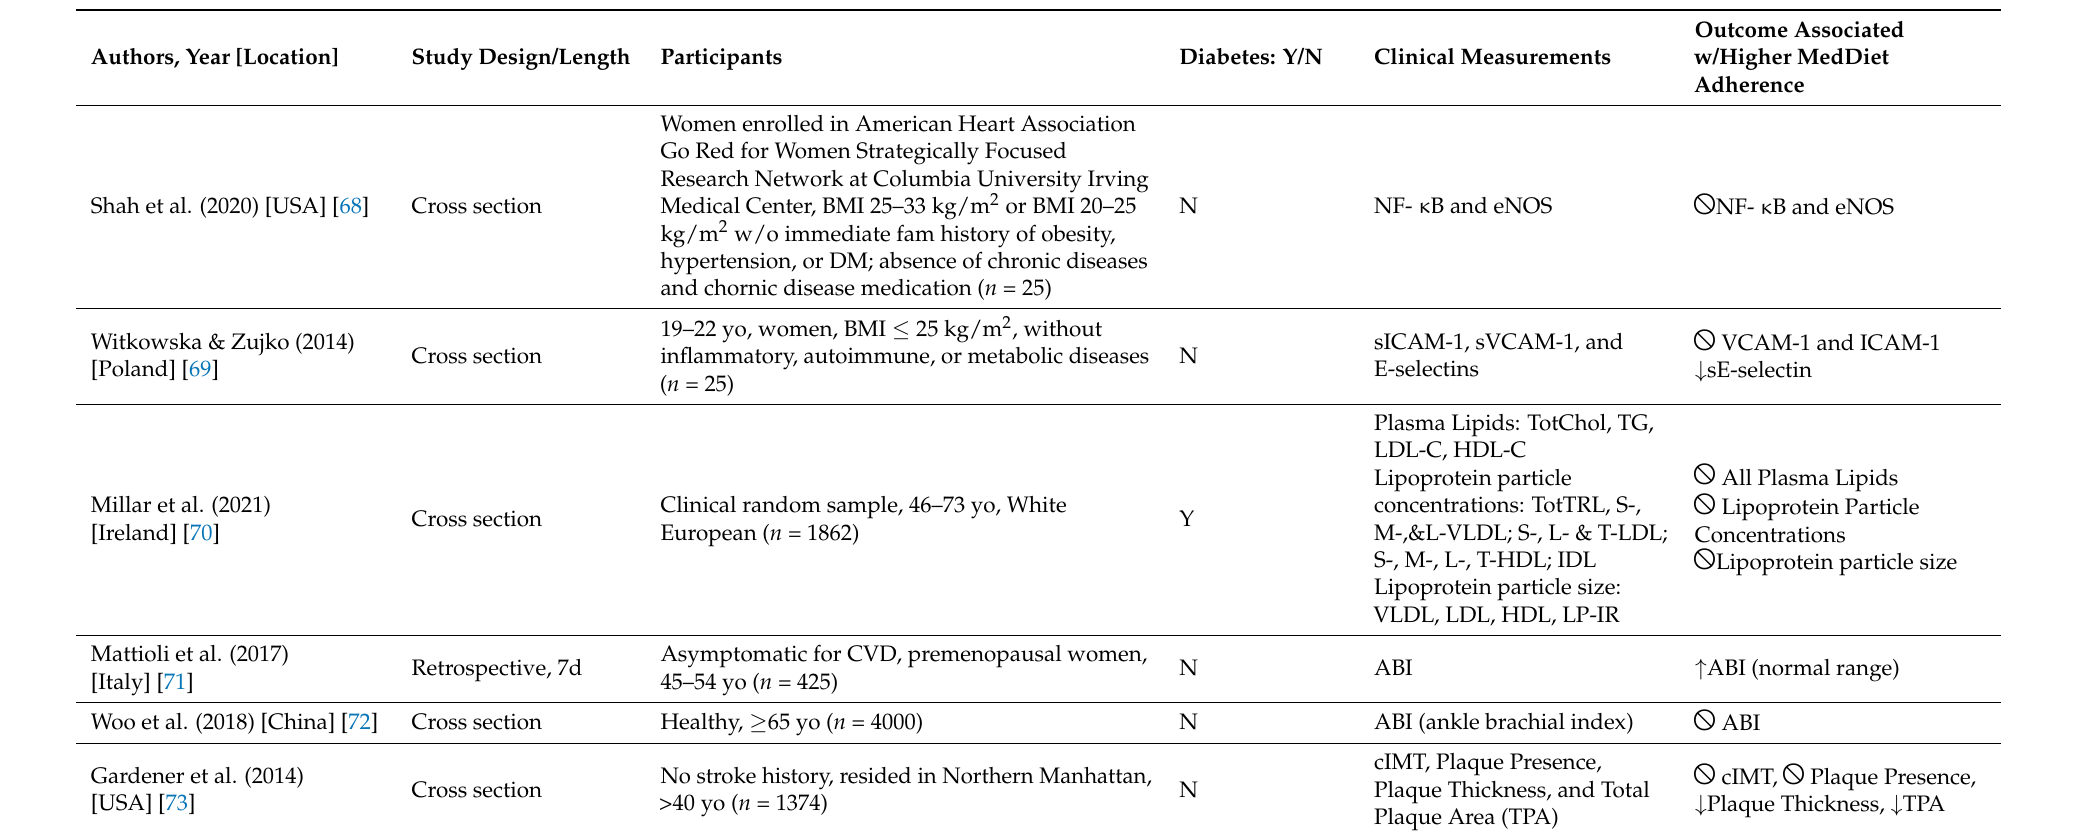
Table 2. Clinical Studies.